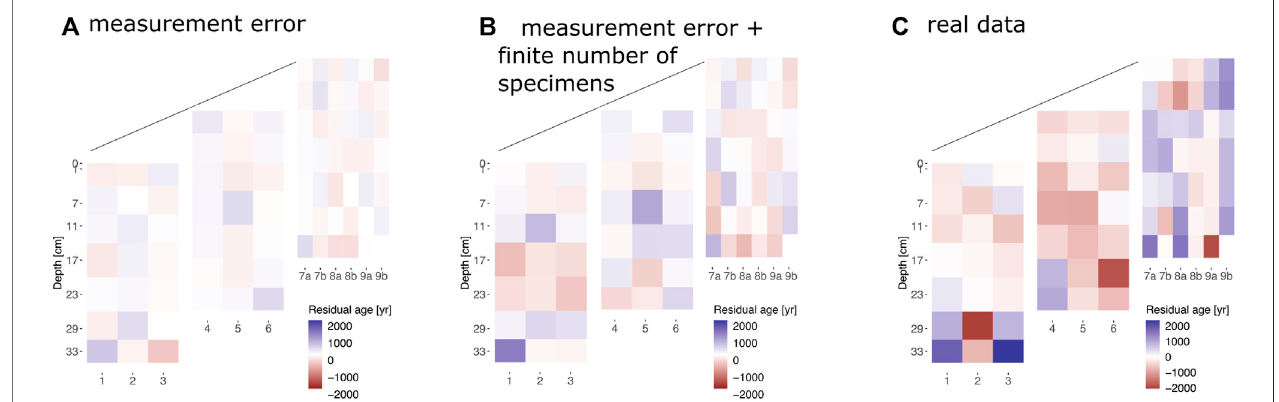
FIGURE 8 | An illustration of the effect of different error terms on the three-dimensional variability of 14 C derived age estimates. The deviations from the mean age per depth layer are smallest considering (A) only a random measurement error (including the calendar age calibration error) and increase when (B) the fi nite number of randomly picked and measured specimens is taken into account. (C) The horizontal age-heterogeneity derived from all sub-cores ( Figure 7 , σ cores ) exceeds both deviations and shows the true age-heterogeneity caused by mixing.